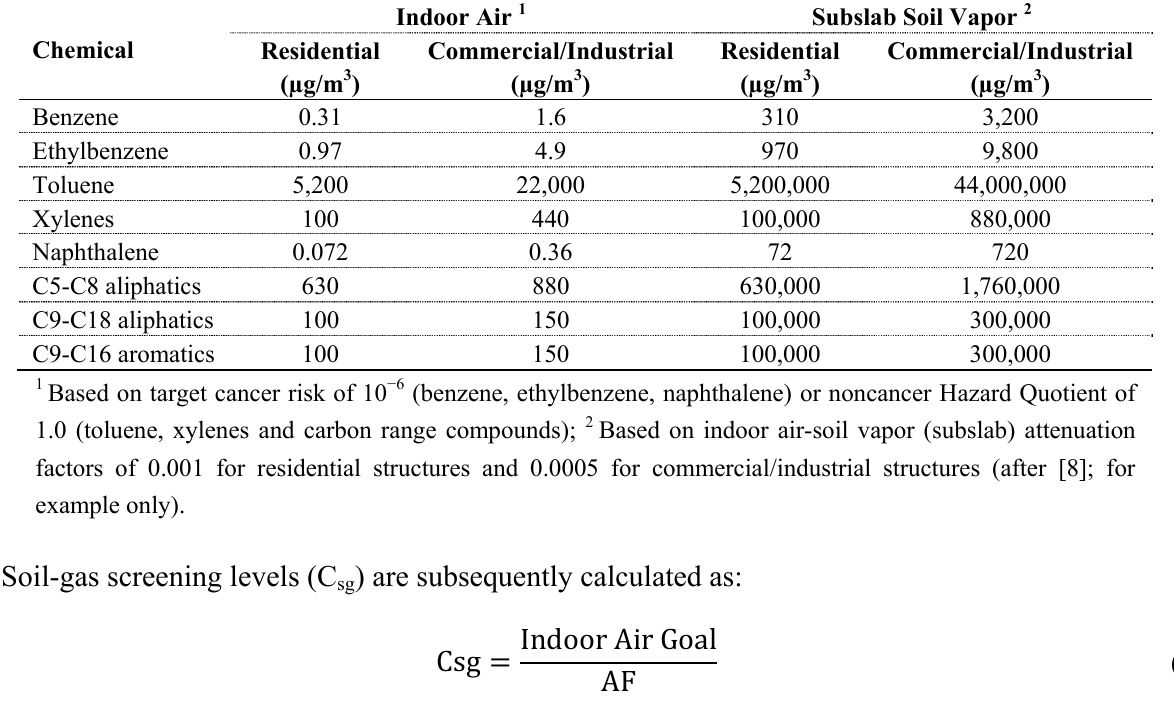
Table 6. Example indoor air and subslab, soil vapor screening levels for petroleum-related chemicals. Indoor Air 1 Subslab Soil Vapor 2 Chemical Residential Commercial/Industrial Residential Commercial/Industrial (µg/m 3 ) (µg/m 3 ) (µg/m 3 ) (µg/m 3 ) Benzene 0.31 1.6 Ethylbenzene 0.97